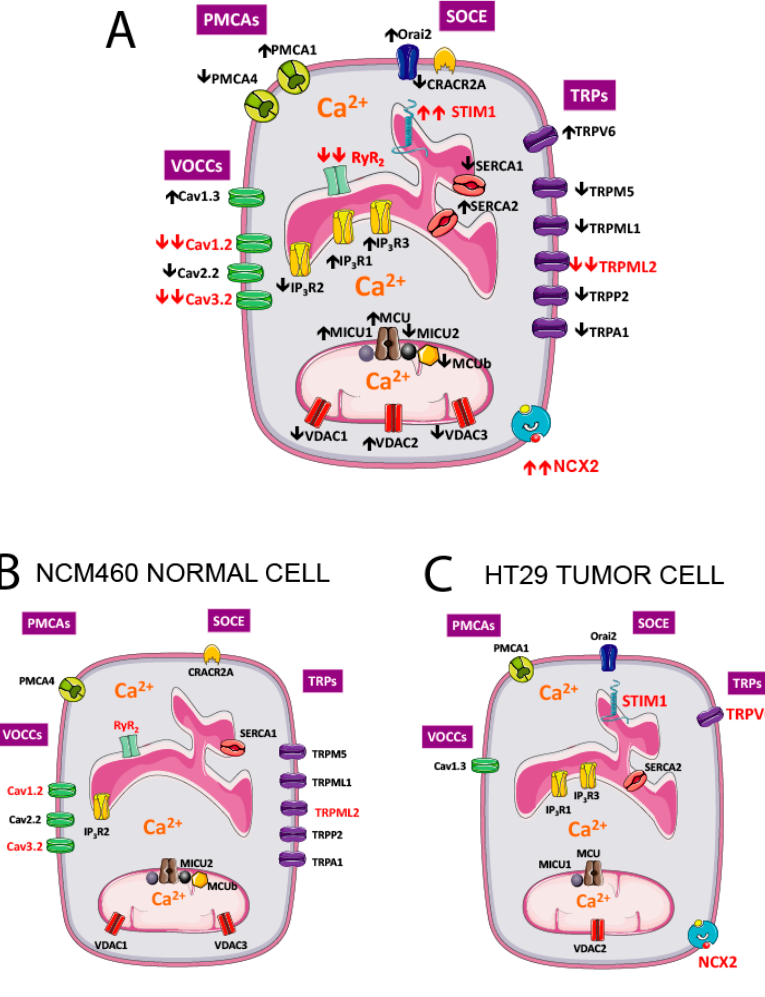
Figure 15. Molecular players differentially expressed in NCM460 normal colonic and HT29 colorectal cancer cells. Genes significantly upregulated ( ↑ ) and downregulated ( ↓ ) in colorectal cancer cells vs. normal colonic cells are shown in specific locations in the plasma membrane, the endoplasmic reticulum (ER) and mitochondria ( A ). To best appreciate the differences, molecular players downregulated in cancer cells have been removed in the prototypical, normal colonic cell ( B ), whereas only genes upregulated in CRC are shown in the prototypic CRC cell ( C ). Molecular players in red are those with the largest fold changes in expression from the normal to the tumor phenotype. PMCAs, plasma membrane calcium ATPases; VOCCS, voltage-operated calcium channels; SOCE, store-operated calcium entry; TRPs, Transient Receptor Potential channels.